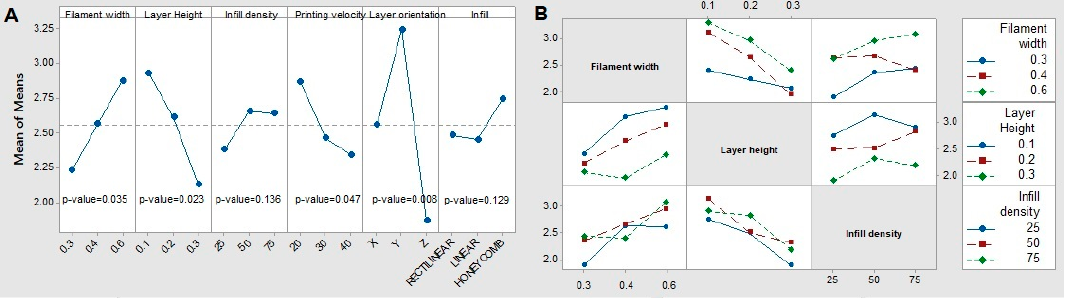
ff ects of ( A ) means and ( B ) interactions on Young’s Figure 10. Main effects of ( A ) means and ( B ) interactions on Young's modulus. Figure 10. Main e